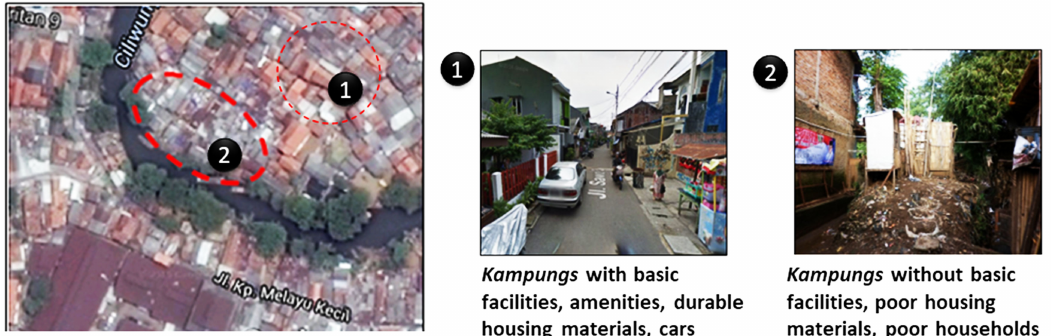
Figure 10. Difference between non-deprived ( 1 ) and deprived kampungs ( 2 ) (Image source: Google Earth image and ground photos J. Pratomo—adapted from [72]).